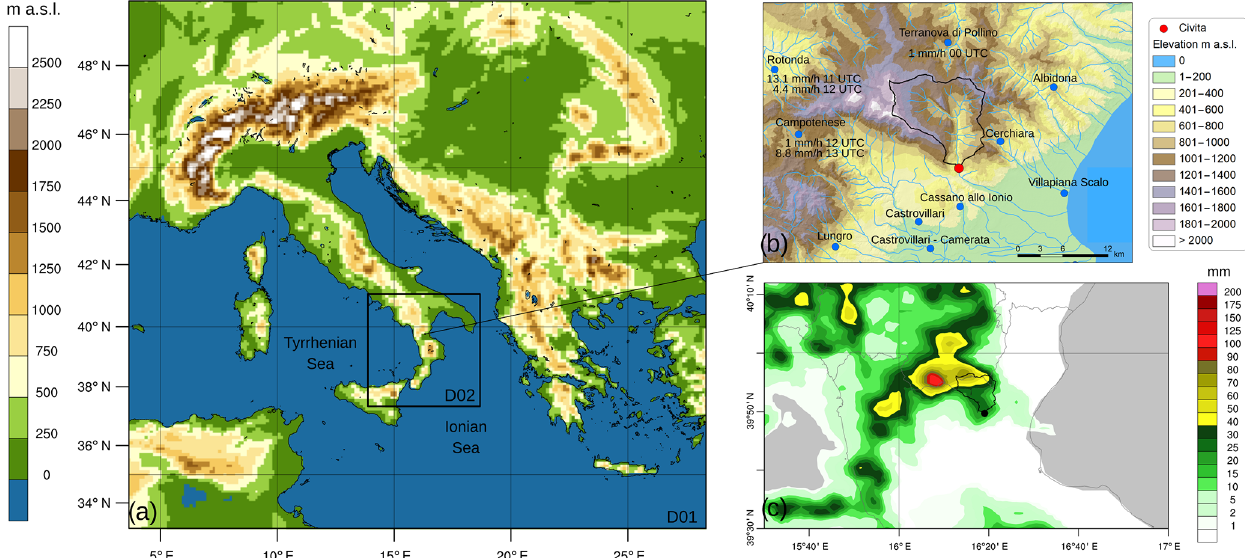
Figure 1. (a) Topographic map of the Italian Peninsula in the Central Mediterranean; the map also represents the two grids adopted for the numerical simulations; (b) a zoom on the northern part of the Calabria region and on the Raganello Creek Catchment (boundaries in black); the map shows the orography and the available rain gauges with the related 24h precipitation recorded; only for the rain gauges where rainfall was recorded, are the related values indicated. A red dot identifies the site of the disaster, near the town of Civita; (c) the 24h cumulated precipitation (mm) simulated by WRF (zoom on the second grid of the model), according to the run RUN_SST_FC (refer to text for details). The boundaries of the Raganello Creek Catchment are highlighted (black line); administrative borders are also shown in light grey, while the disaster site is identified by a black